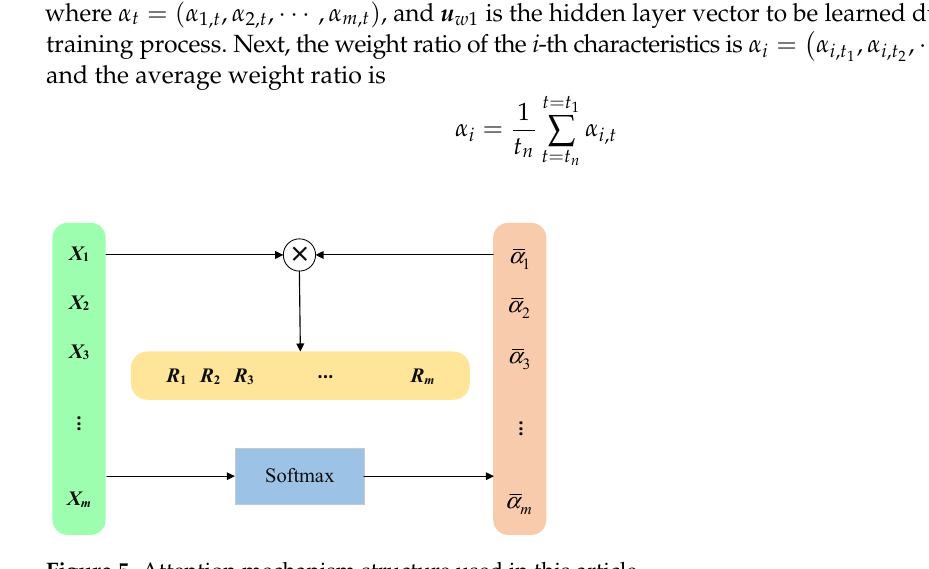
Figure 5. Attention mechanism structure used in this